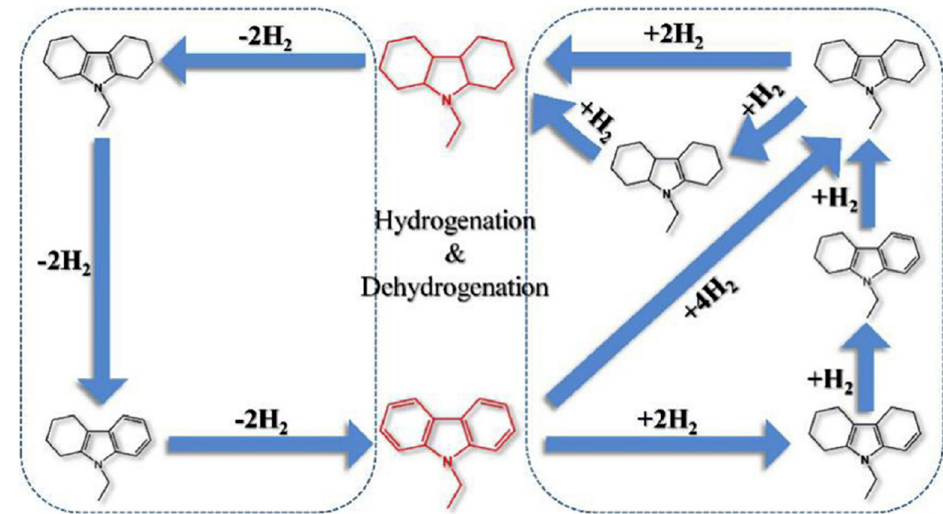
Figure 4. Hydrogenation ( right ) and dehydrogenation ( left ) pathways between NECZ and 12H-NECZ; copyright (2020), Elsevier.